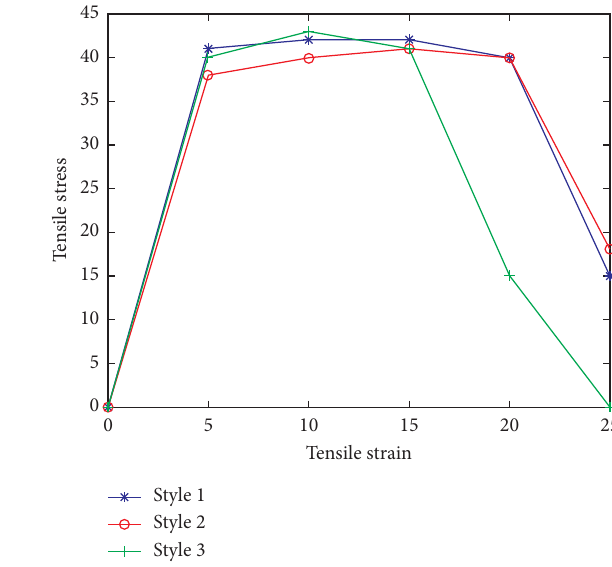
Figure 1: Print error results.